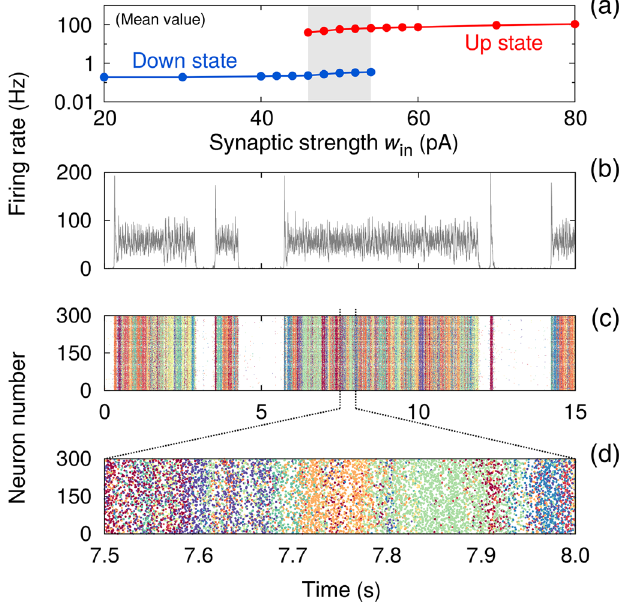
FIG. 1. Numerical integration of the model of Millman et al. [44] with N ¼ 300 neurons. (a) Phase diagram of the mean firing rate as a function of the synaptic strength parameter w . For low values in of w , the stable state is a quiescent state with very low levels of in activity (down state), whereas for large values of w , the system in exhibits high levels of activity (up state). Both states coexist for intermediate strength values (shaded region), allowing for up-and- down transitions. Importantly, the transition is discontinuous. ¼ 50 pA illustrate (b) Time series of the network firing rate for w in the system ’ s bistability, with eventual (stochastic) jumps between up and down states. (c) Raster plot (for the same times as above) in which distinct colors are used for different causal avalanches. (d) Raster plot zoom (broken lines) demonstrating the intermingled and temporally overlapping organization of different causal ava- lanches. Model parameters have been set as in Ref. [44] (see Appendix